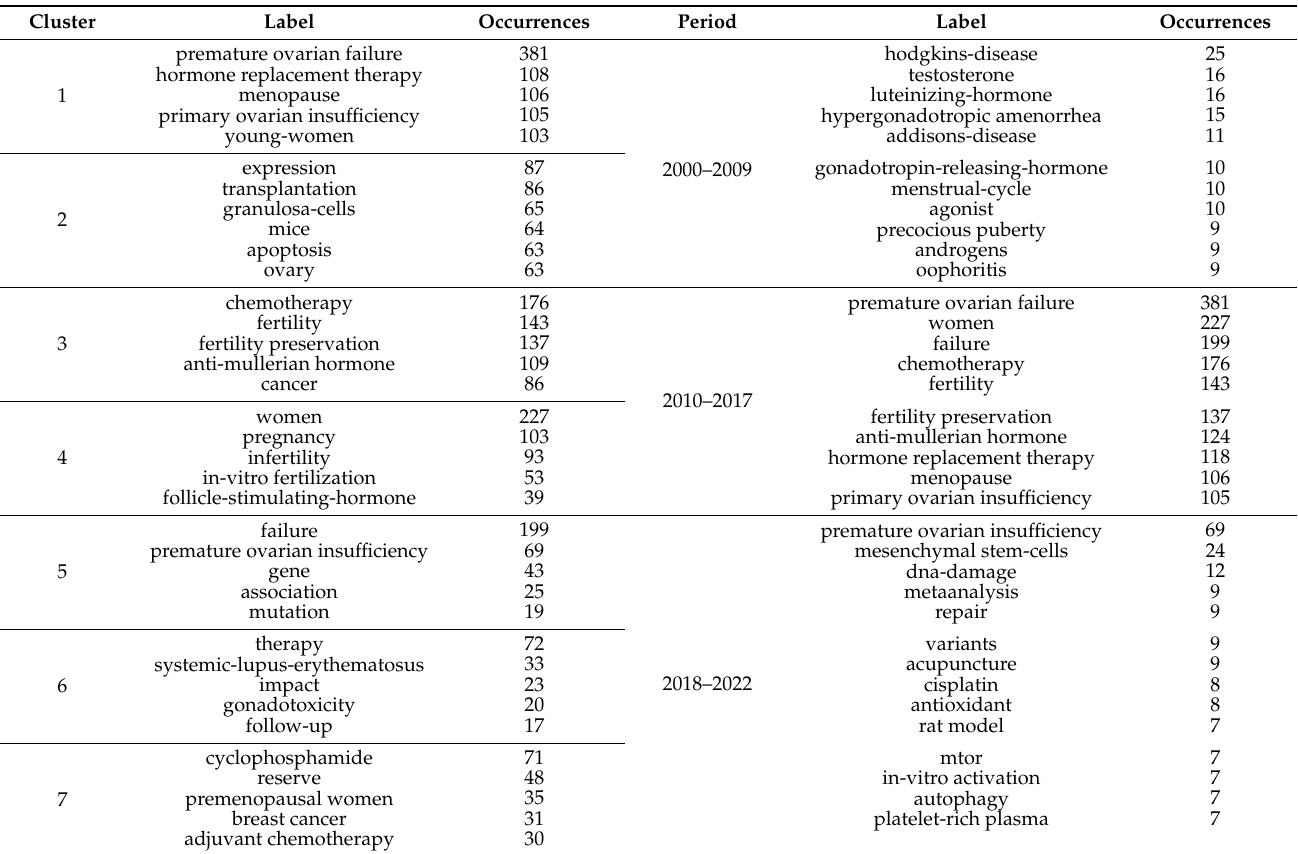
Table 5. Top 5 keywords in each cluster and top 10 keywords in each stage on therapy for POI from 2000 to